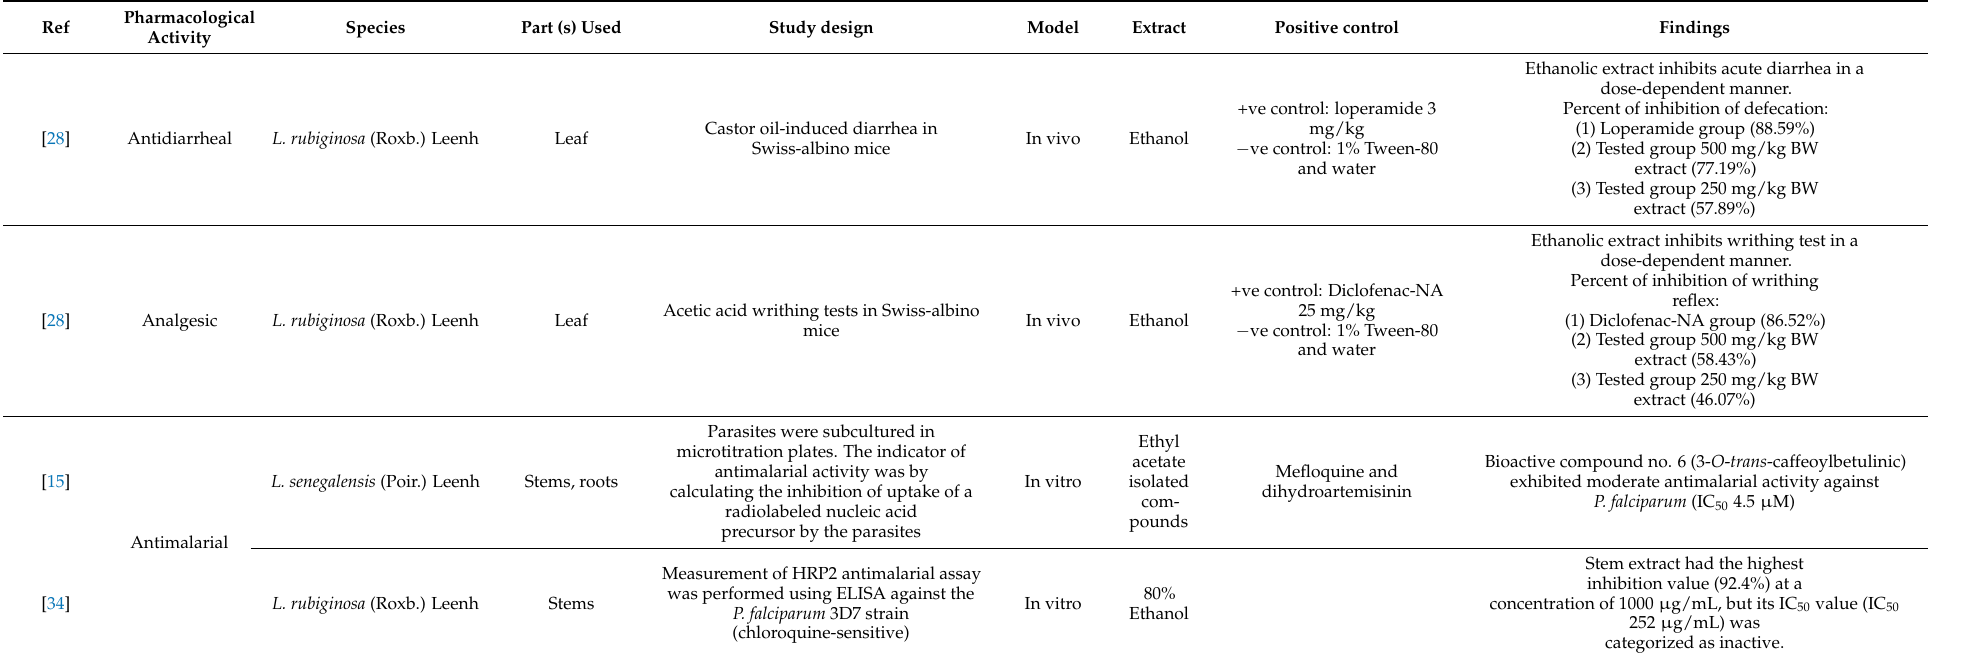
Table 7. Summary of the methods and other pharmacological activities of genus Lepisanthes